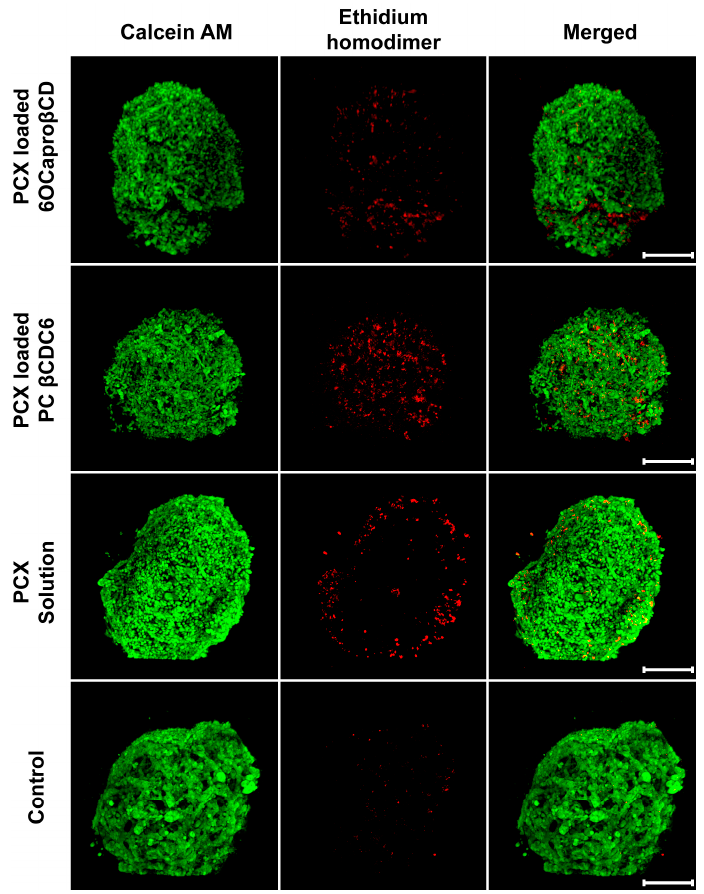
Figure 7. Antitumoral effectiveness of paclitaxel-loaded cyclodextrin nanoparticles and paclitaxel solution on 3D spherical breast tumor viability. Three-dimensional (3D) spheroids were incubated with complete DMEM alone observed as a control group. 4T1 cells were seeded at 1 × 10 4 cells per well into 96-well U-bottom plates, formulations were added to the spheroids, and the plates were returned to the incubator for 48 h of culture. Calcein AM (live, green fluorescence) and ethidium homodimer (dead, red fluorescence) reagents were added to the wells, and plates were incubated for an additional 45 min (scale bar: 500 µM).